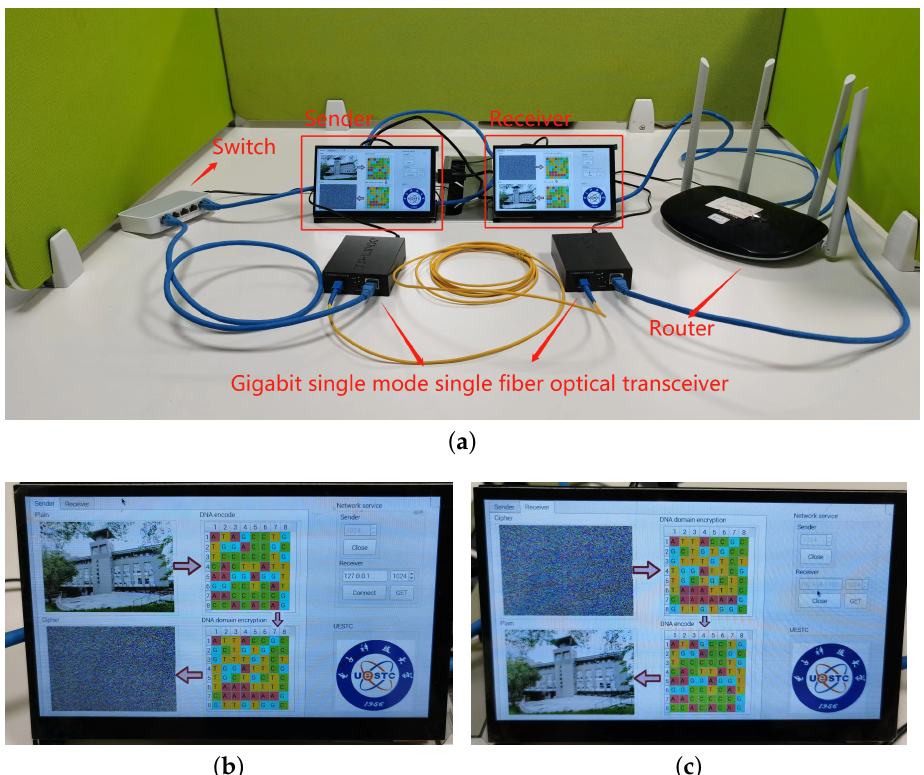
Figure 5. Experimental result in Optical Access Network secure communication platform: ( a ) The overall physical diagram; ( b ) 4 # plain image; ( c ) Cipher image of ( b